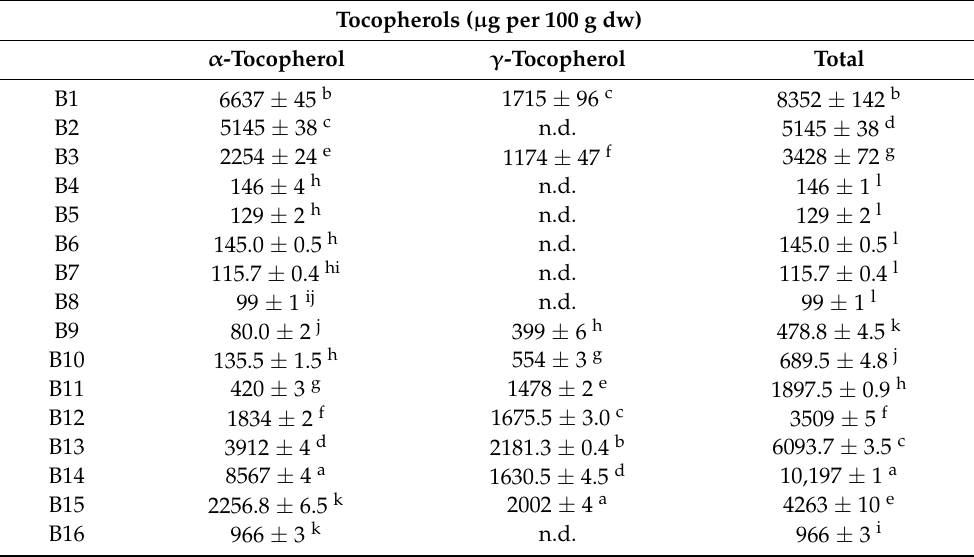
Table 2. Tocopherols of Cynara cardunculus L. blades collected at different growth